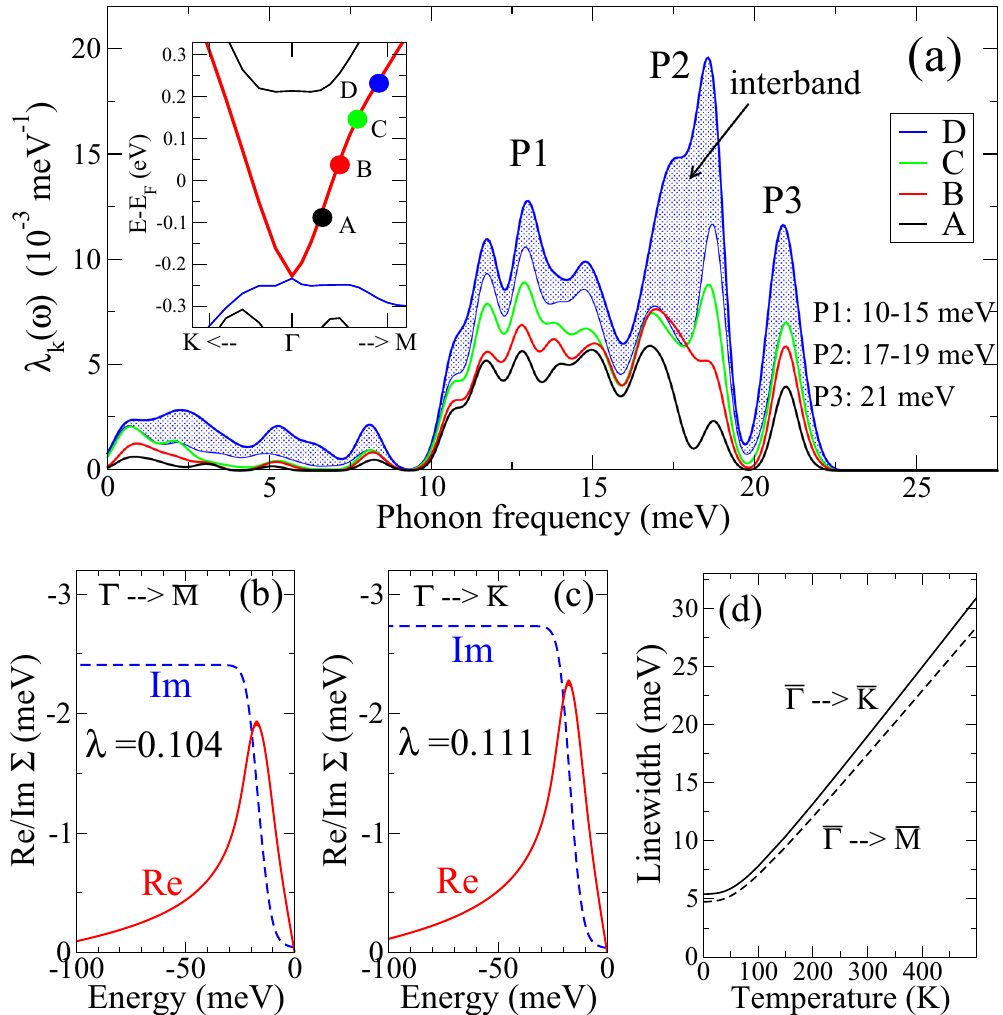
Figure 2. ( a ) Spectral representation of the coupling for four different states (A–D) of the upper cone surface state along the Γ M direction for the 3QL slab of Bi 2 Se 3 . The position of the states is indicated in the inset. P1–P3 denote the energies of the three dominant contributions. The shaded area represents the interband contribution for state D. ( b , c ) Real and imaginary part of the self-energy for two states with energies E − E F = 200 meV along ( b ) Γ M and ( c ) Γ K , evaluated for T = 20 K. ( d ) Temperature dependence of the electronic linewidth (full width at half maximum) for the two states of ( b , c